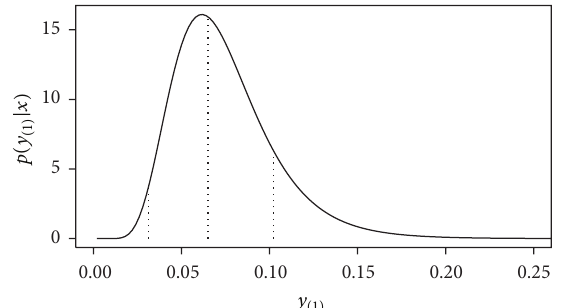
and the histogram plot of simulated 𝛼 and 𝛽 are plotted in Figure